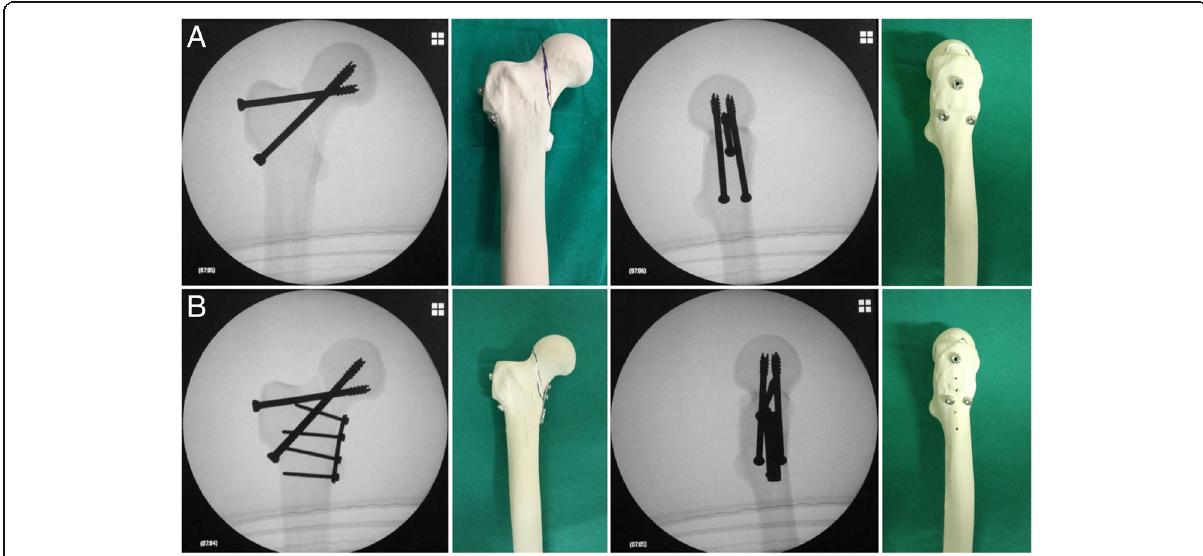
Fig. 1 a . Group 1 - Assembly with two parallel cannulated screws in the inferior portion of the femoral neck + the Pauwels screw: fluoroscopy in the coronal and sagittal planes, and photographs of one of the specimens prior to testing, anterior and lateral views. Note the parallel arrangement of the two inferior screws in the coronal and sagittal planes. Also note how the Pauwels screw occupies the central space of the femoral neck in the sagittal plane; b . Group 2 - Assembly with two parallel cannulated screws in the inferior portion of the femoral neck + the Pauwels screw + medial plate: fluoroscopy in the coronal and sagittal planes, and photographs of one of the specimens prior to testing, anterior and lateral views. Note the parallel arrangement of the two inferior screws in the coronal and sagittal planes. Also note how the Pauwels screw occupies the central space of the femoral neck in the sagittal plane. Observe that only 1 of the 4 screws of the plate was placed proximally to the osteotomy site – this was done to reproduce what normally occurs in the clinical situation, where it is almost impossible in the majority of patients to position the plate in a complete medial position – it is more anteromedial to the lesser trochanter – and also to put it more proximally, due to the inferior